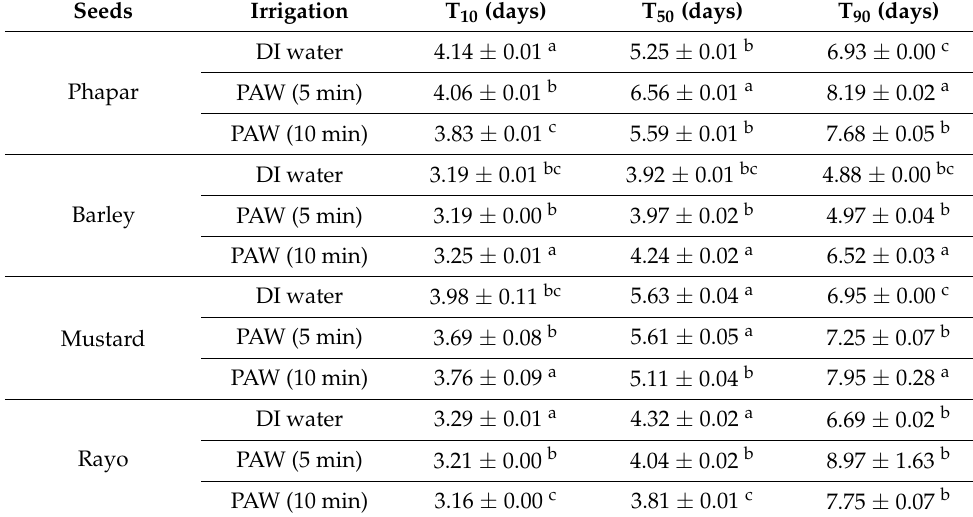
Table 2. Computation of T 10 , T 50 , and T 90 of the irrigated seeds. Seeds Irrigation T 10